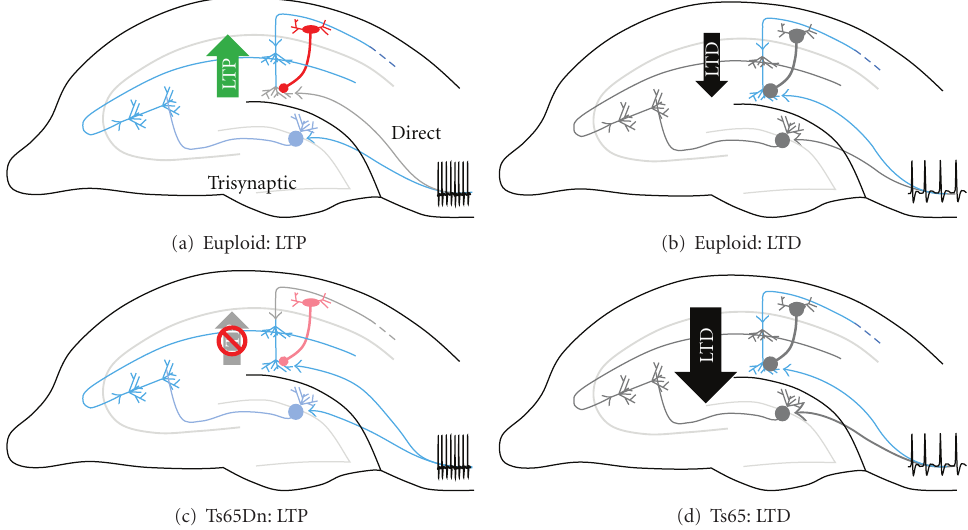
Figure 3: Potential impact of altered synaptic plasticity on hippocampal processing in Ts65Dn mouse model of Down syndrome. Schematic of two main pathways through hippocampus arriving from the entorhinal cortex: temporoammonic (TA)—direct to CA1 distal dendrites; trisynaptic pathway from DG through CA3 to proximal CA1 dendrites. LTP and LTD are proposed to minimize interference between the two pathways [50, 131]. (a) In euploid hippocampi, high-frequency inputs induce LTP in CA1 resulting in enhanced suppression of inputs from TA by feed-forward inhibition arising from interneurons in stratum oriens. (b) Low-frequency inputs depress the trisynaptic pathway releasing distal CA1 dendrites from feed-forward inhibition and allowing information to flow through the TA pathway. (c) In Ts65Dn hippocampi, aberrant LTP in CA1 results in diminished feed-forward inhibition during high-frequency activity allowing TA inputs to become superimposed on those flowing through the trisynaptic pathway. (d) Enhanced LTD would be expected to facilitate flow of low- frequency information through the direct TA pathway in Ts65Dn